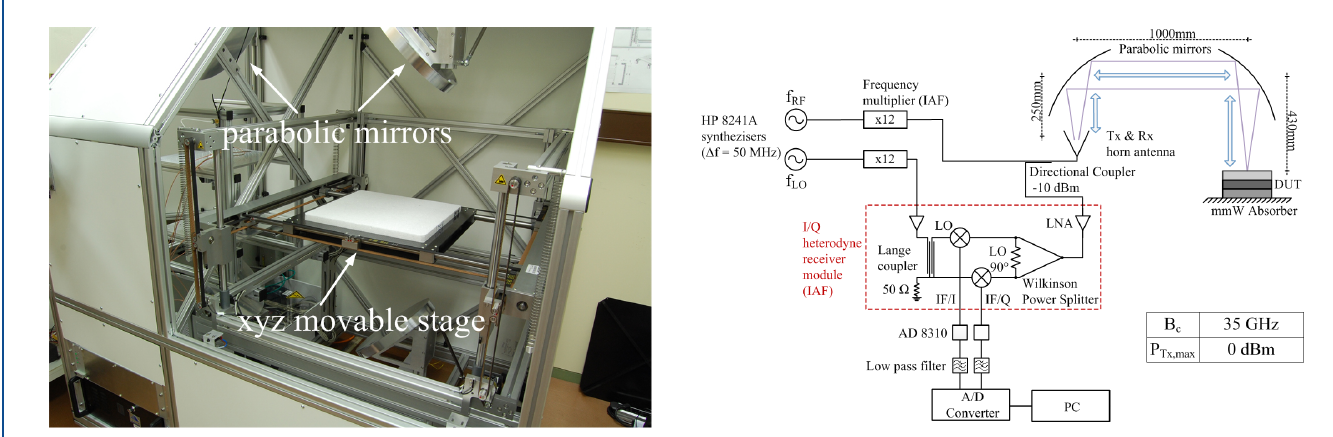
Figure 1. Photograph of the mmW focusing system. Figure 2. Block diagram of the millimeter wave imaging system used for reflectometric measurements.